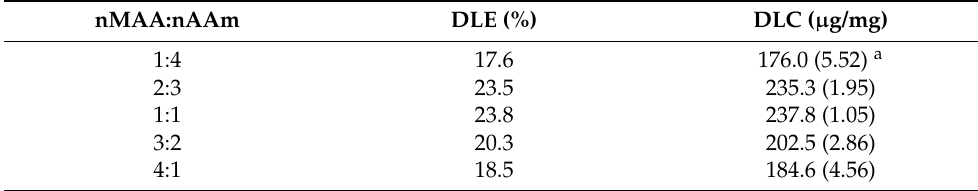
Table 4. Effects of the monomer molar ratios on the drug loading content and